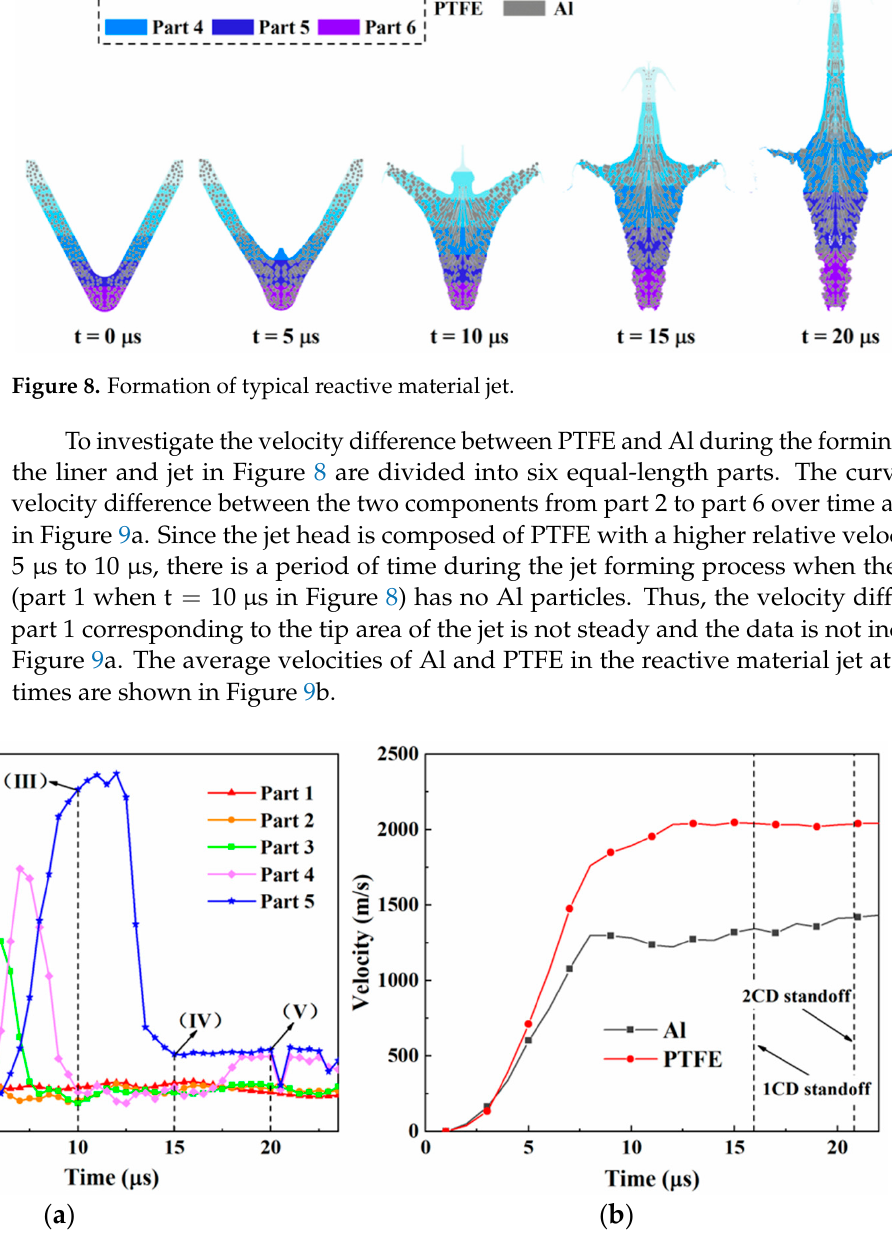
Figure 9. Velocity–time curve of the Al and PTFE in the reactive material jet: ( a ) the velocity difference between PTFE and Al of each part versus time; ( b ) the velocity of total Al and PTFE versus time.